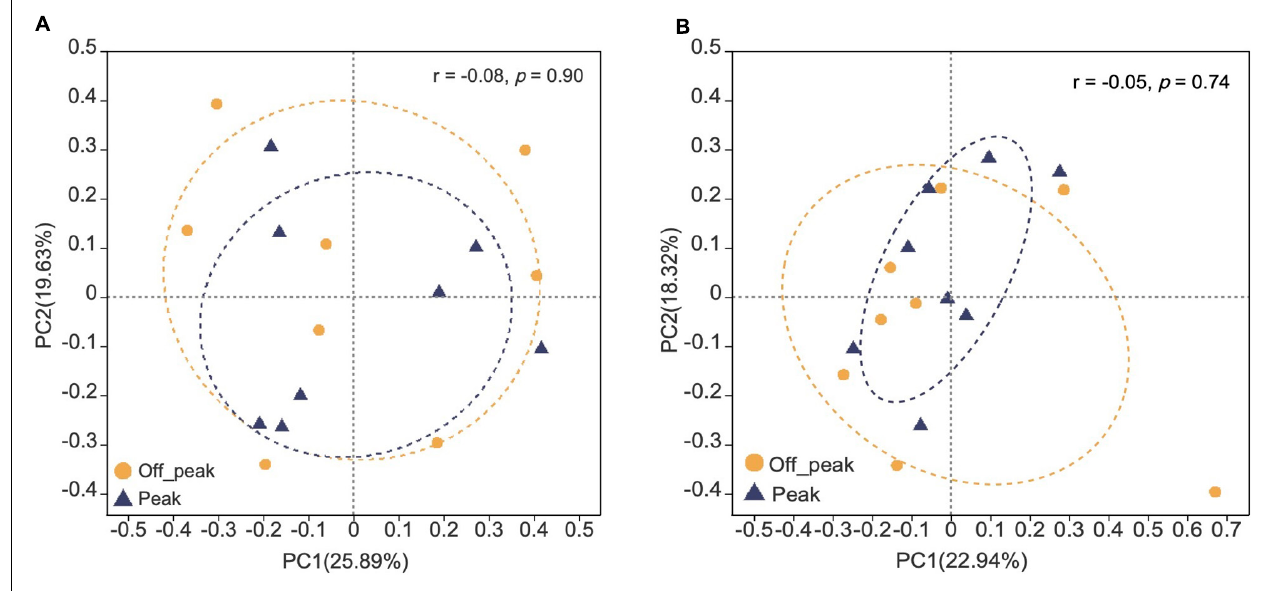
FIGURE 9 | Principal co-ordinate analysis (PCoA) plots of fungal communities in peak and off-peak periods at canteens (A) and dormitories (B) based on Bray–Curtis distance. The r and p -values of analysis of similarity (ANOSIM) are shown in each figure.